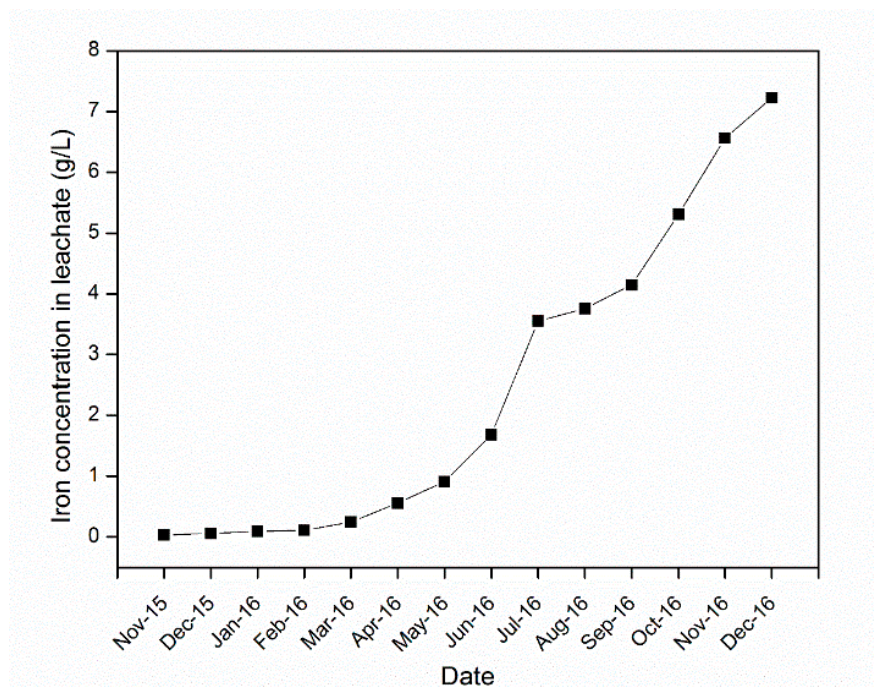
Figure 8. Iron concentration of the leachate during the heap bioleaching of P3C6.